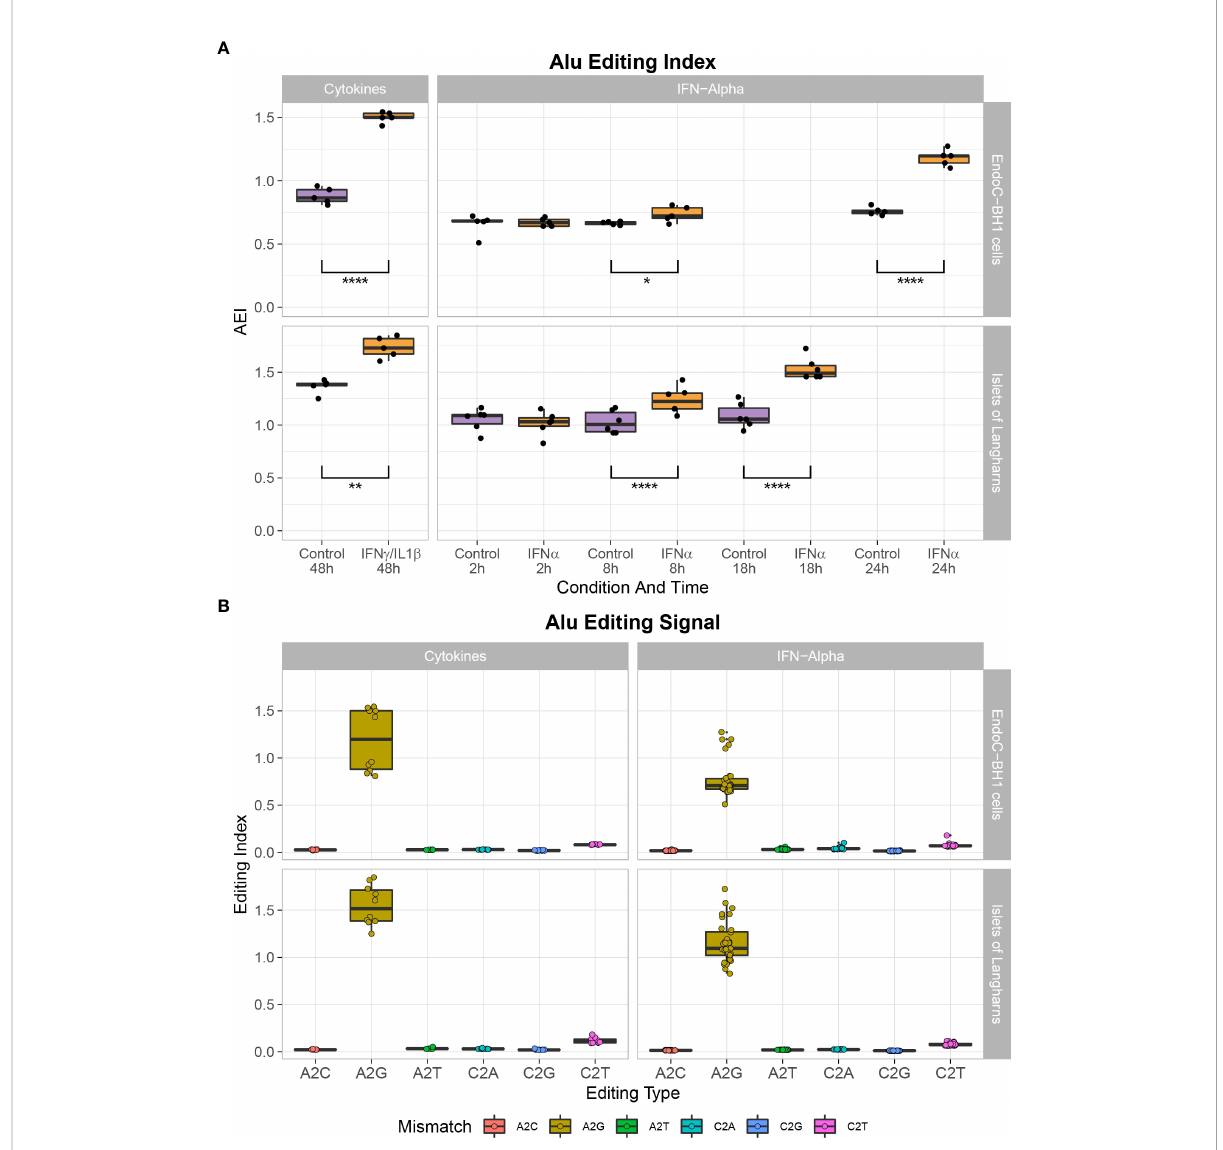
FIGURE 2 Cytokine treatment leads to A- to I- mutation in EndoC- b H1 and primary human islets. (A) Global A-to-I RNA editing index across Alu elements (short interspersed nuclear elements) in RNA-seq data demonstrates a higher A-to-I editing signal in IFN a or IFN ɣ /IL1 b stimulated samples after 8 hours and 48 hours, respectively. Student ’ s paired two-tailed t-test; *P<0.05, **P<0.005, ****P<0.0001. (B) Noise levels (non-A-to-G mismatches) are notably lower than seen in the global editing index ’ s biological signal (A-to-G